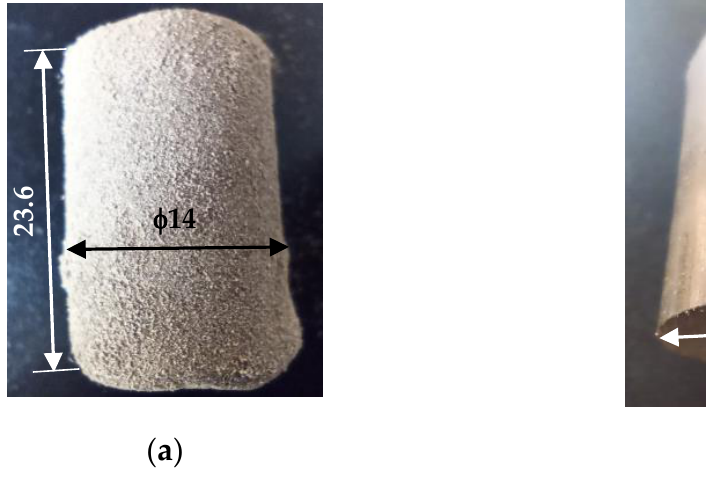
Figure 2. Bronze powder samples: ( a ) green compact, ( b ) sintered compact.